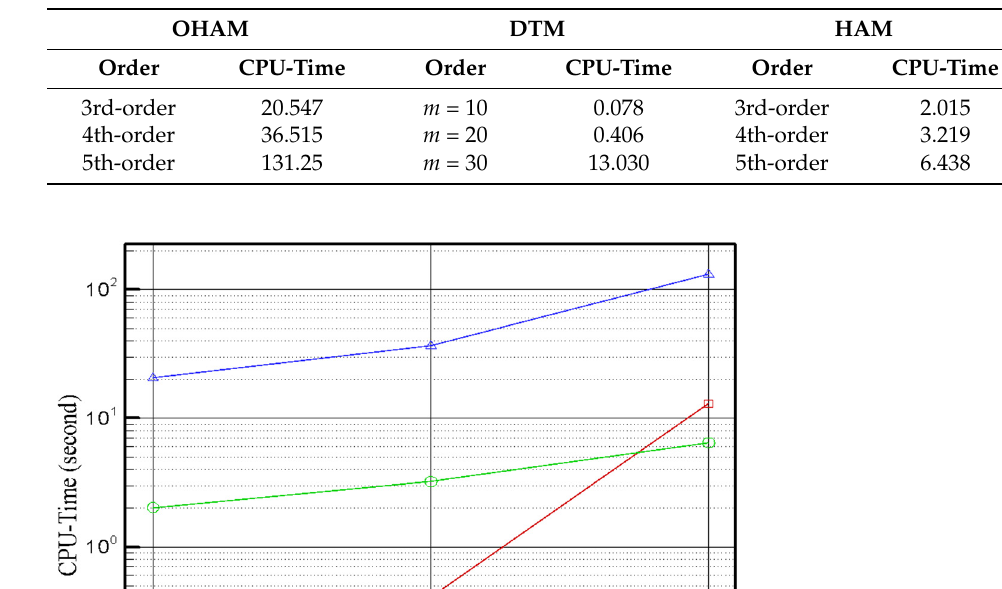
Figure 3. The analytical results for uc / x obtained by the HAM at different orders of approximation compared with the numerical results Re = 5 and α = − 1. Table 5. Comparison of CPU time (second) given by OHAM, DTM and HAM at different orders of approximation for the case of Re = 5 and α = 1.